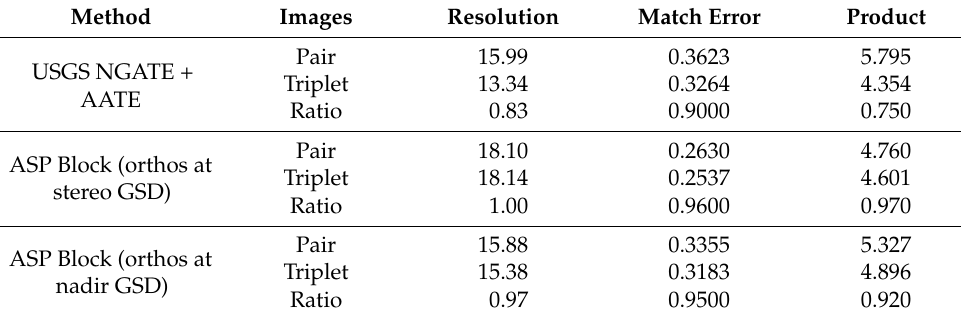
Table 3. Effect of adding HRSC nadir image to pair of stereo